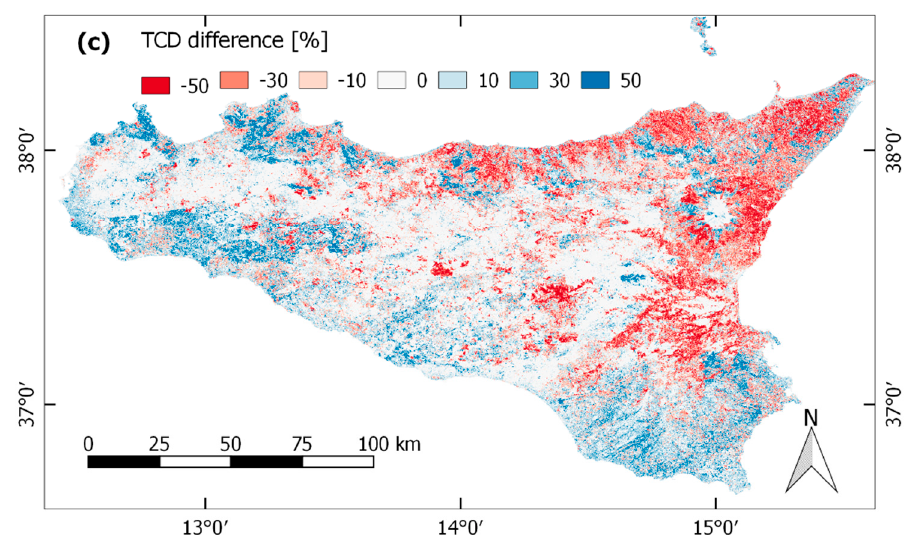
Figure 14. Detailed tree cover density (TCD) maps over Sicily from ( a ) Sentinel-1, ( b ) Copernicus High Resolution Layers (HRL) and ( c ) the difference map between the two datasets (Copernicus HRM map was subtracted from Sentinel-1 TCD map).